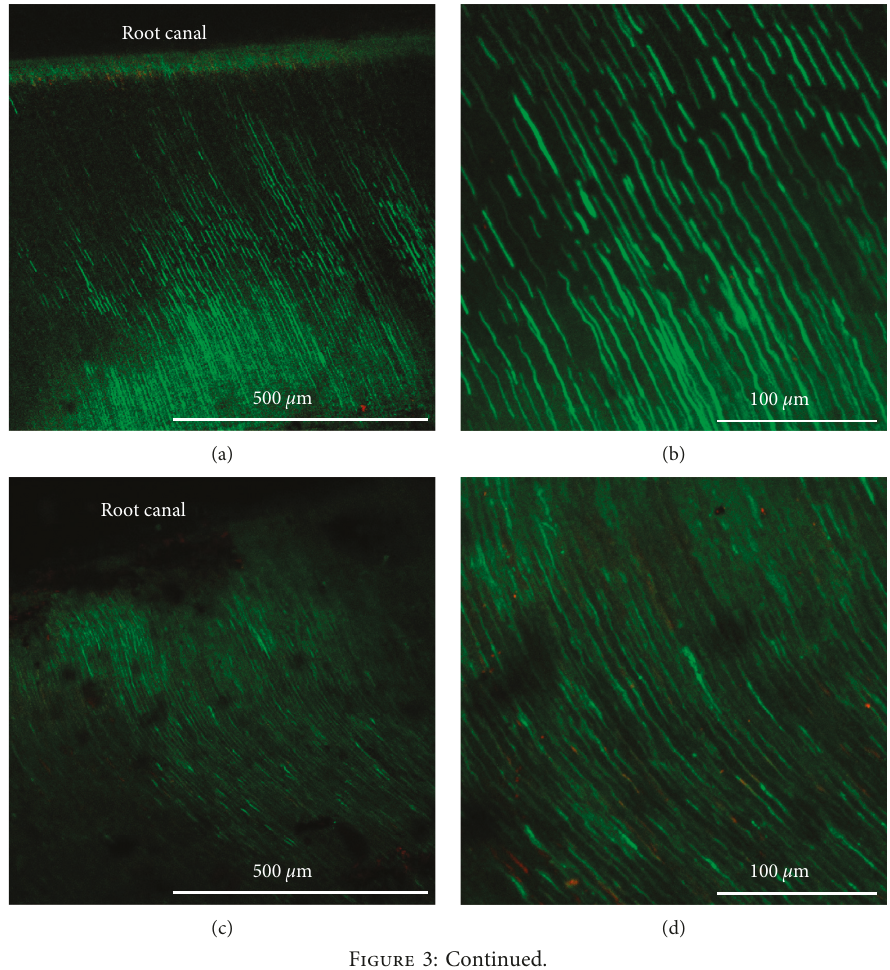
P SD. 0 . 05, n (cid:31) ∗ ± <